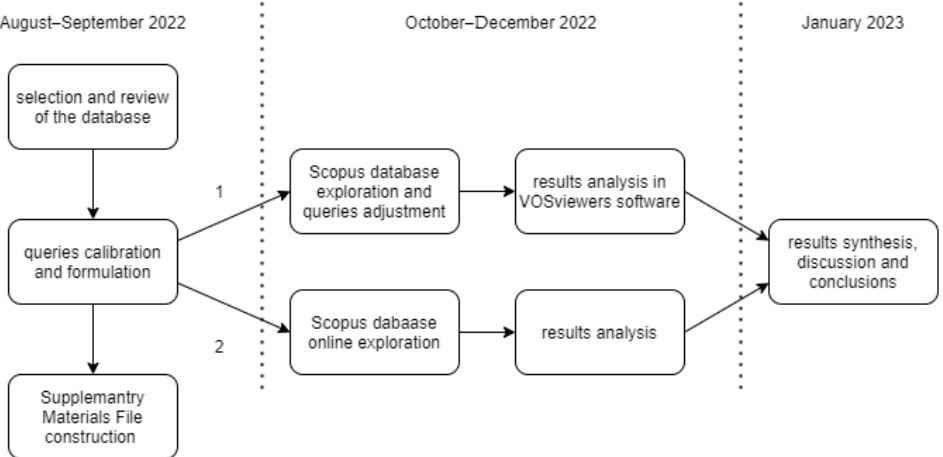
Figure 1. Methods and stages of the research . Source: Authors’ elaboratio n.